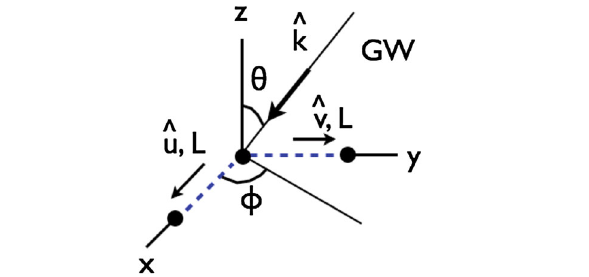
Fig. 28 Geometry for calculating the difference in the round-trip light-travel times in the two arms of a Michelson interferometer: ˆ k = −ˆ n is the direction of propagation for a plane gravitational wave; ˆ u and ˆ v are unit vectors that point from the vertex of the interferometer (e.g., the beam splitter) to the two end masses; and L denotes the lengths of each of the arms in the absence of a gravitational